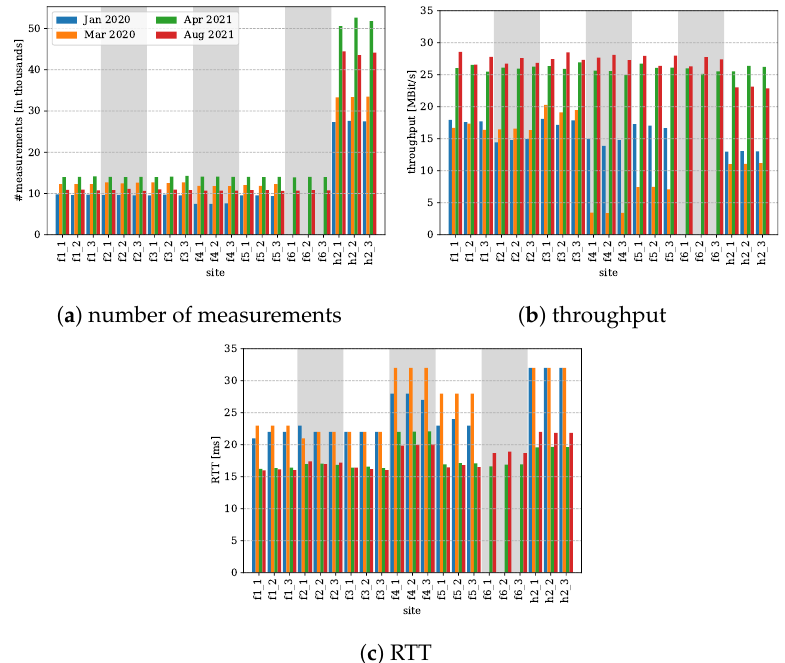
Figure 6. Number of measurements, throughput, and RTT for all machines in Frankfurt (f) and sites are f1, ..., f6, and h2 with the machines numbered from one to